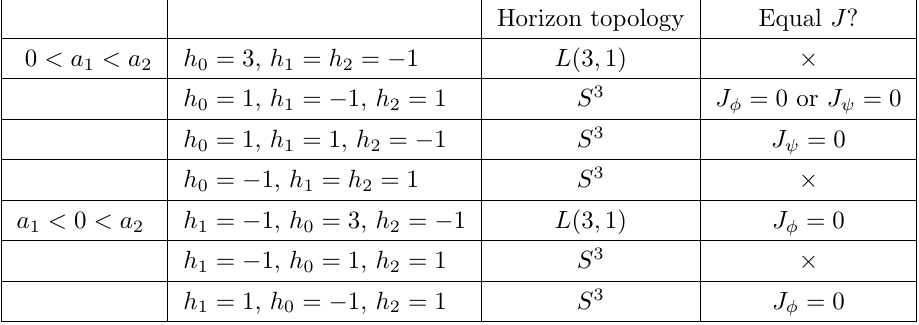
Table 1. 3-centred single black hole solutions that allow for equal angular